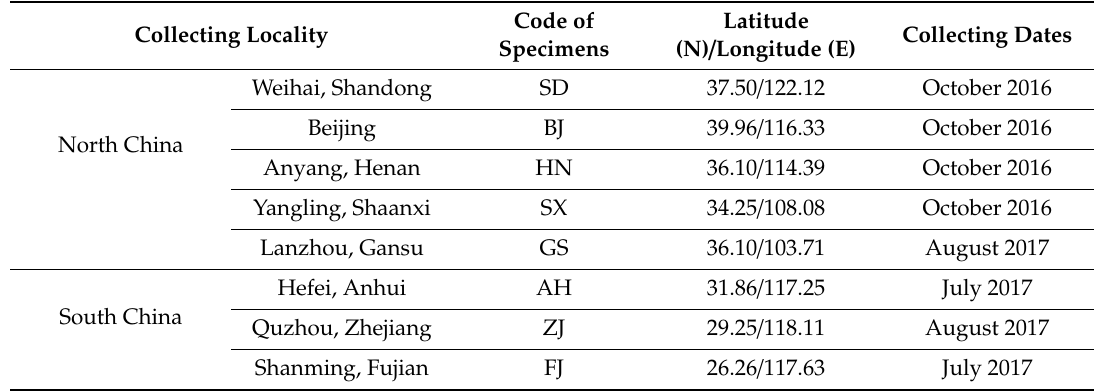
Table 1. Collecting information for Lycorma delicatula